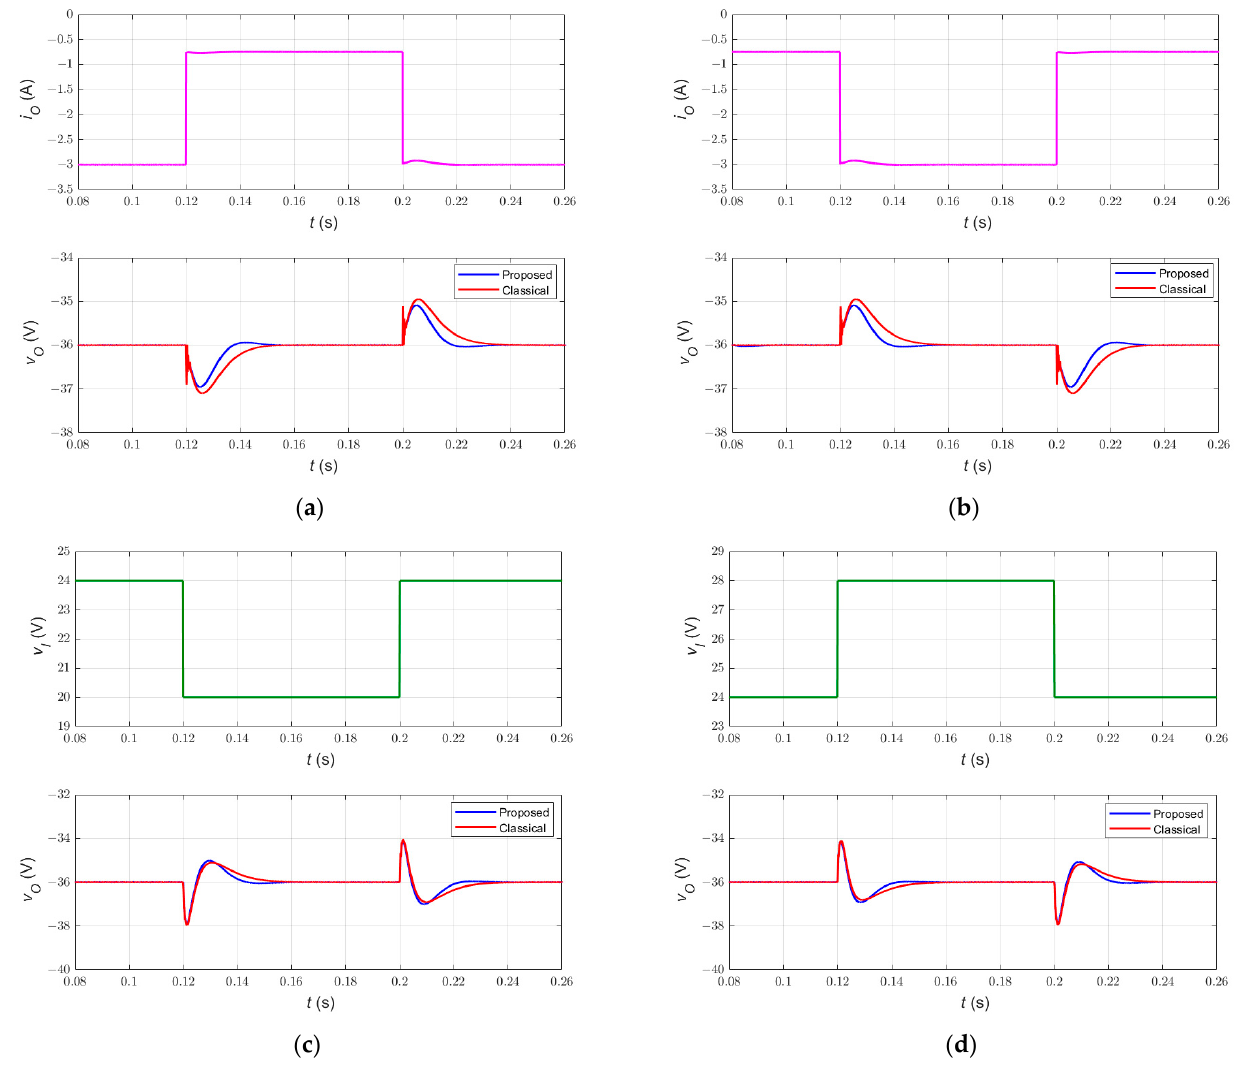
Figure 8. Comparison between the response of the proposed and classical double-integral sliding- mode current control of the PWM DC-DC Cuk converter under line and load disturbances. The response during step ( a ) decrease and ( b ) increase in load current i O . The response during step ( c ) decrease and ( d ) increase in input voltage v I . Table 4. Comparison between classical and simplified DI-SMC of DC-DC Cuk